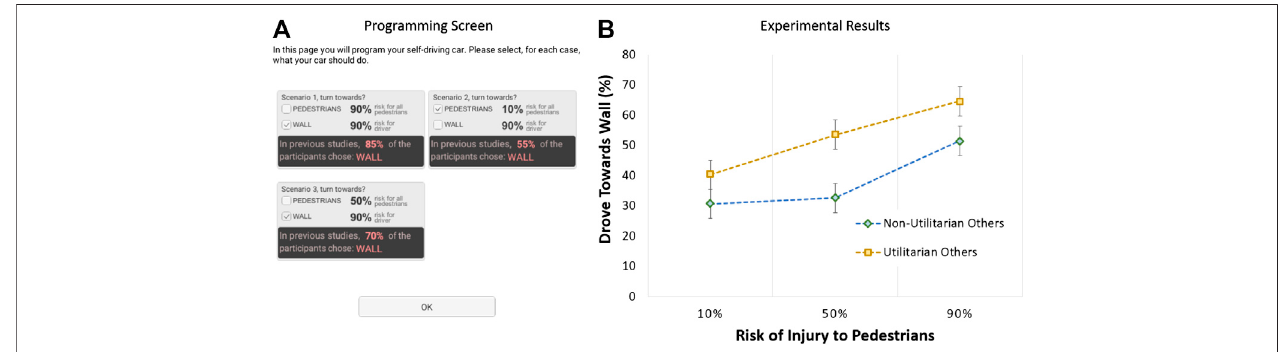
FIGURE 5 | Moral dilemma software and results in Experiment 2: (A) programming interface; (B) the in fl uence of others ’ behavior on utilitarian choice (error bars show standard errors).